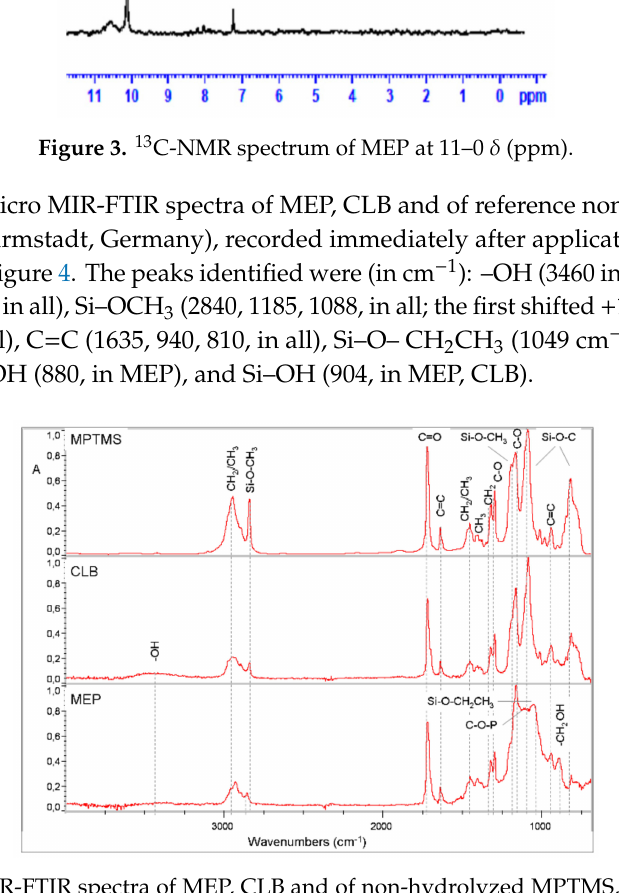
Figure 4. Micro MIR-FTIR spectra of MEP, CLB and of non-hydrolyzed MPTMS, immediately after application to the Ge